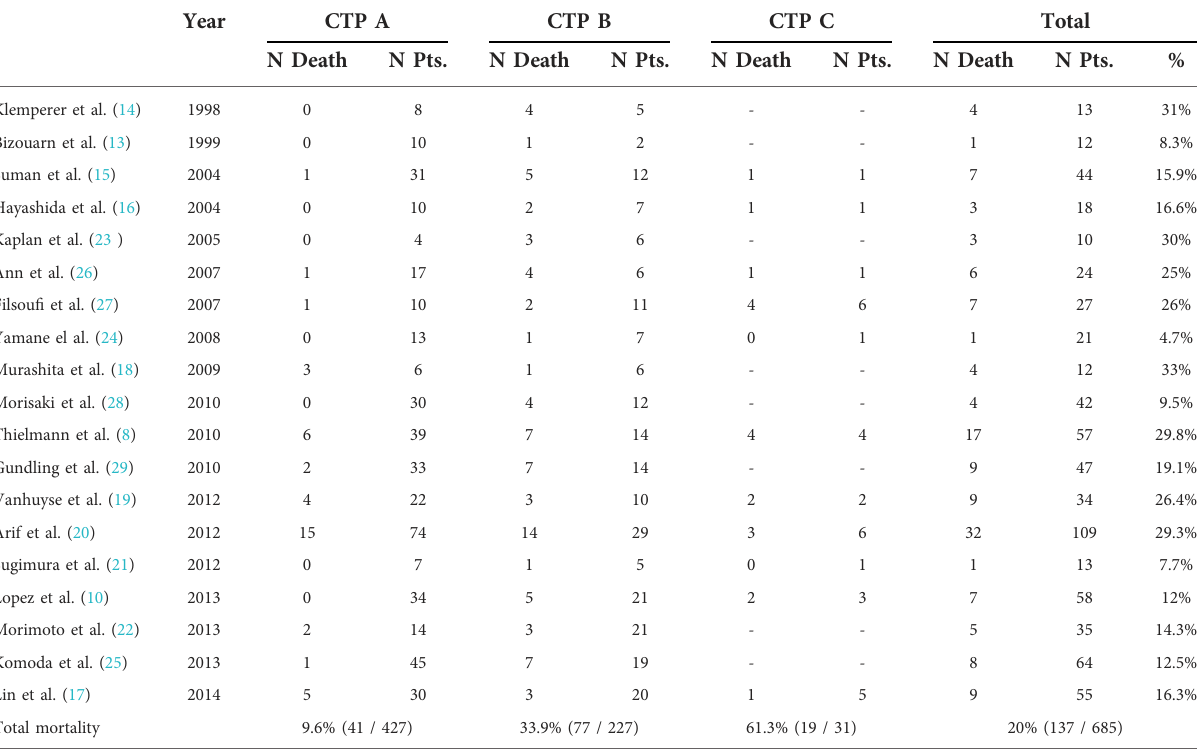
TABLE 4 Associated in-hospital mortality of patients with liver disease who undergo cardiac surgery based on child-turcotte-pugh score (2, 8, 10, 13, 14 – 25)